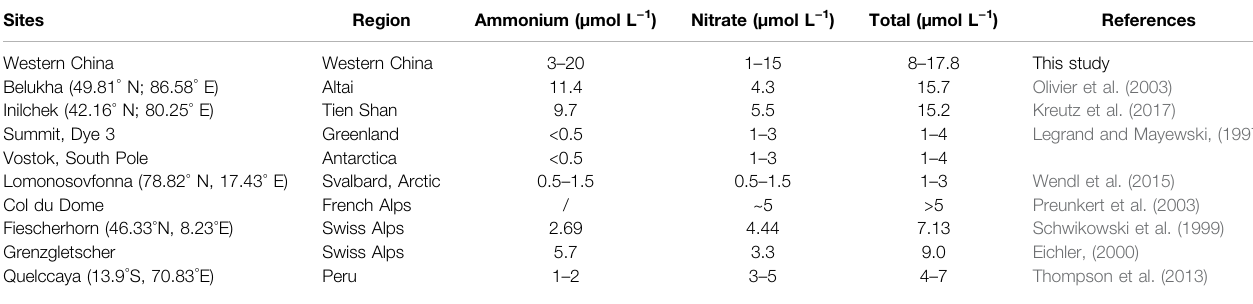
TABLE 1 | Nitrogen concentration archived from modern snow/ice records around the world.